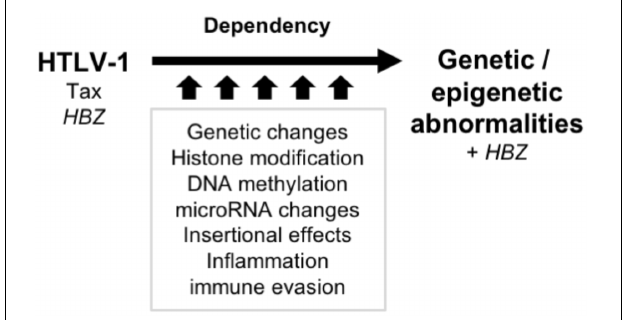
FIGURE 1 | Transition of the molecular characteristics during latent period. The acquired cellular characteristics such as promoting cell proliferation and apoptotic resistance are conferred by viral genes in early-phase infected cells and by genetic/epigenetic abnormalities in late-phase ATL cells. The aberrant characteristics are acquired and imprinted, nevertheless Tax disappears. The consequent genotype and epigenotype support the differential phenotypes and the disease